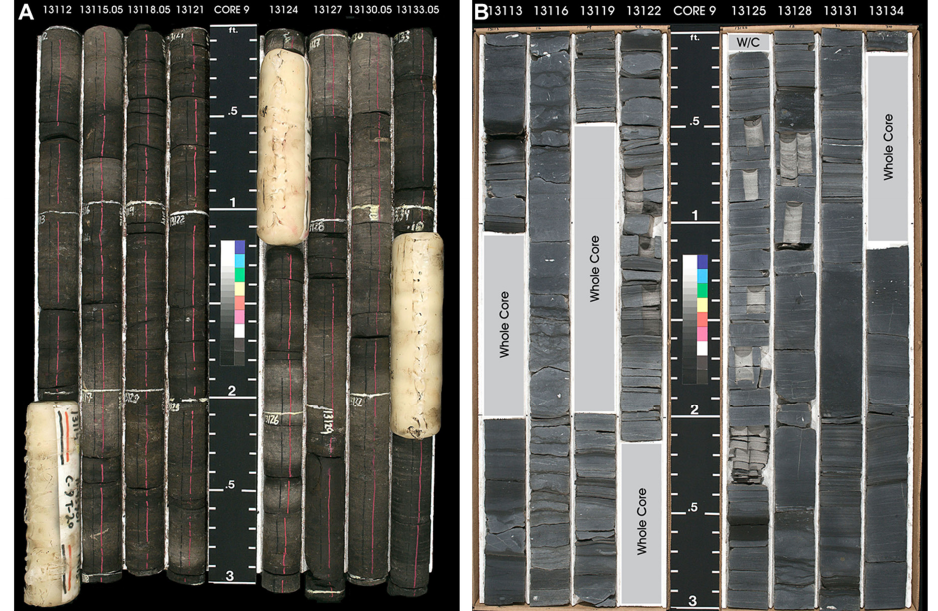
Figure 4. Core ( A ) Sectioned ( B ) Slabbed from Haynesville–Bossier formation stored in a warehouse in North Wales (https://science4cleanenergy.eu/resources/shale-core-rock-samples/), in boxes and trays of appropriate dimensions, with corresponding depth indicated in feet. The core has been sectioned/slabbed to facilitate transportation and storage. Sections of the core are waxed for preservation. The colour variation of the shale core is related to their deposition under anoxic (dark shales) through suboxic (light shales) to oxic conditions, marked against a colour bar ranging from anoxic (dark grey) to oxic (whitish). Red and black lines help in orienting the shales, with white marks indicating depths. Inserts help to prevent any movement, thus maintaining stability. Slabs follow fissility planes. Background geological and geochemical information are available in [54].